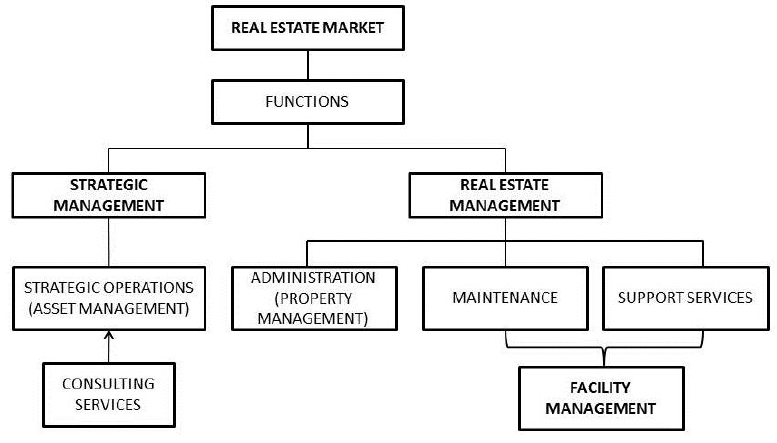
Figure 1. Real Estate Management—Asset, Property, Facility.